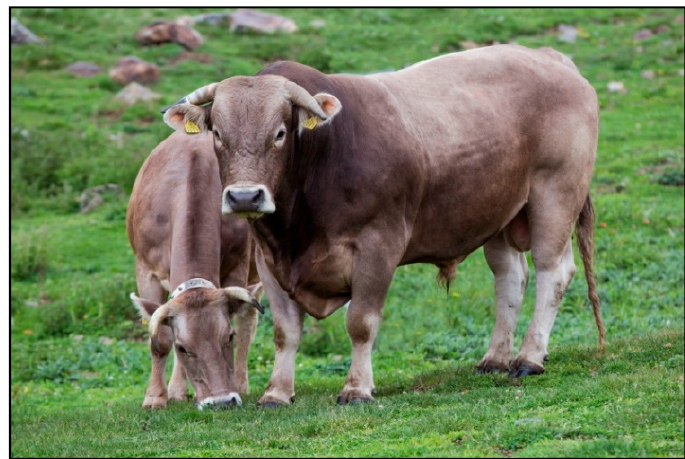
Figure 6. Adult female and male BA cattle. Source: Natàlia Montané.